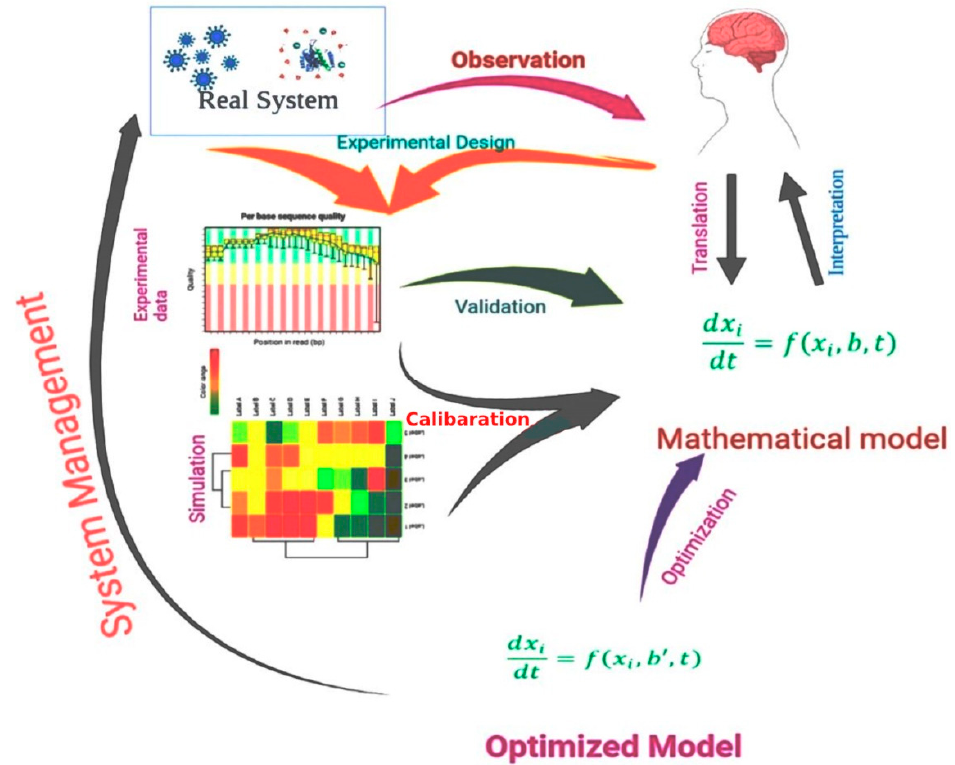
Figure 1. A schematic representation of a mathematical model, including experimental design, ex- perimental data analysis, model optimization, and model validation, used in modern drug design approaches.